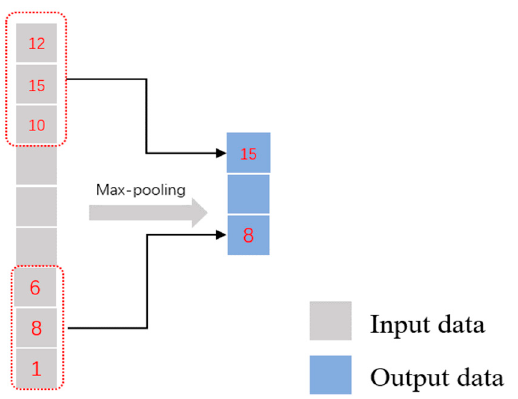
Figure 8. Max pooling operation.